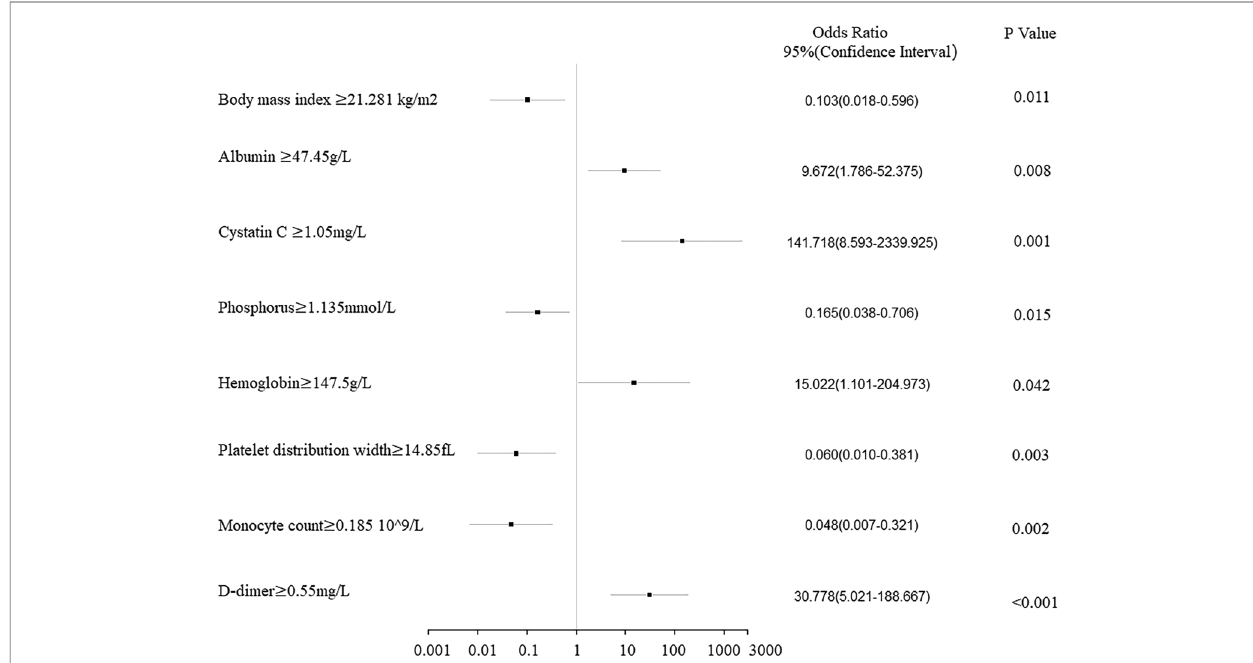
FIGURE 1 | Forest plot analysis of the clinical characteristics and hematological indicators of 114 breast cancer patients related to the pathologic complete response rate after neoadjuvant chemotherapy.